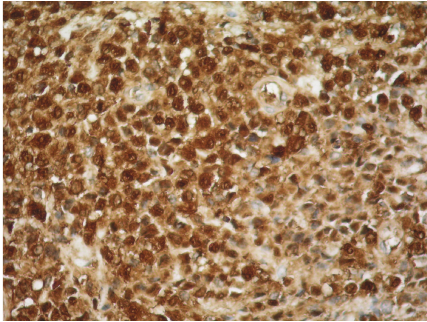
Figure 1: Vulvar lesion of Langerhans cell histiocytosis.